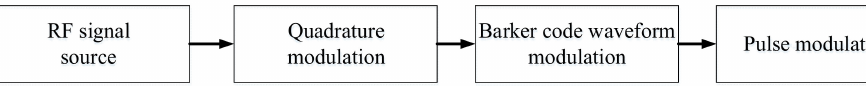
Figure 2. The simulation flow of bi-phase-coded pulse.